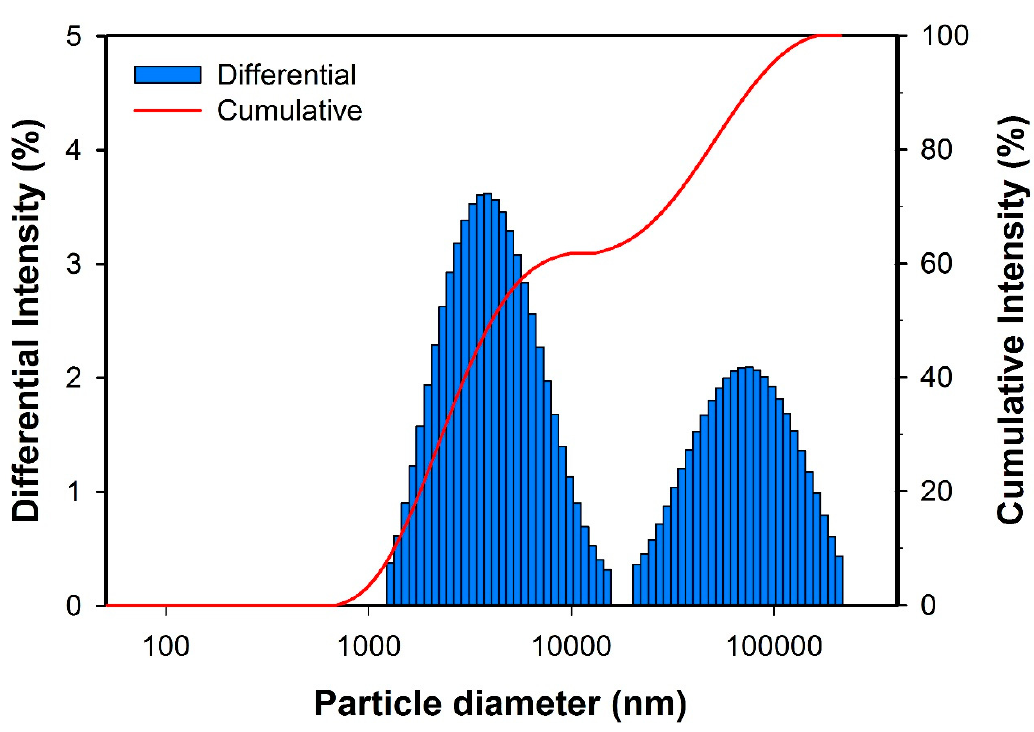
Figure 3. Particle size distribution of aragonite seed prepared at 2-h reaction time. The weak second peak might be caused by aggregation of the aragonite particles shown in the first peak.